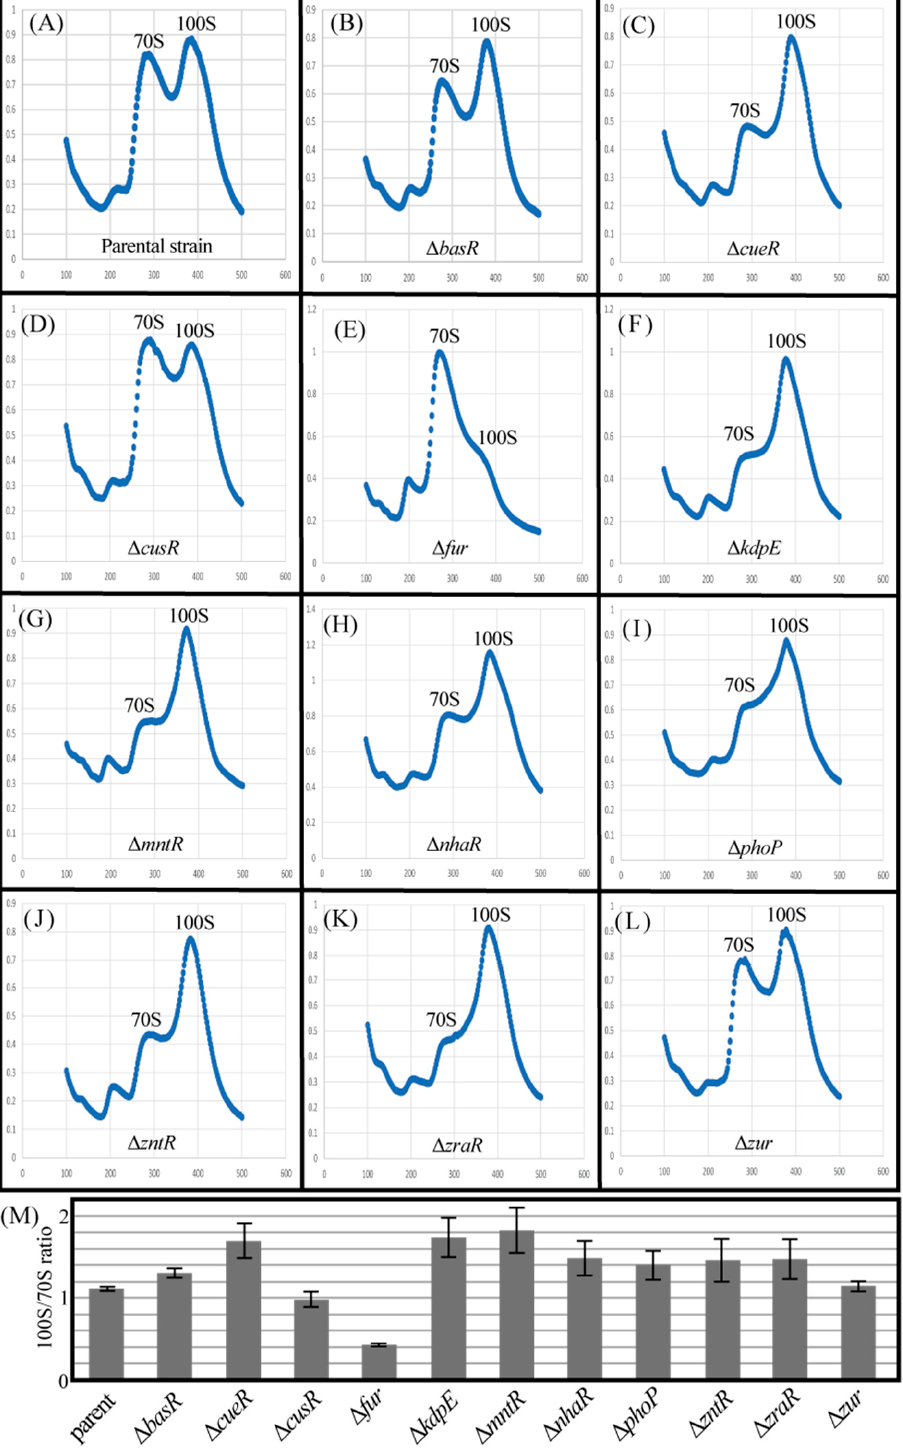
Figure 6. Influence of lack of metal-responsive TFs on the formation of 100S ribosome dimers. Each strain was harvested 24 h after inoculation. ( A – L ) The cell lysate of each strain was subjected to sucrose gradient centrifugation to monitor ribosome patterns. ( M ) For peak separation analysis, the level of 70S and 100S ribosomes was estimated using Systat software (Systat Software, Chicago, IL, USA). The quantitative ratios of the 70S and 100S ribosomes (100S/70S ratio) were calculated, and the values for each mutant were normalized against the value of their corresponding parent. Notably, the experiments were repeated at least three times.